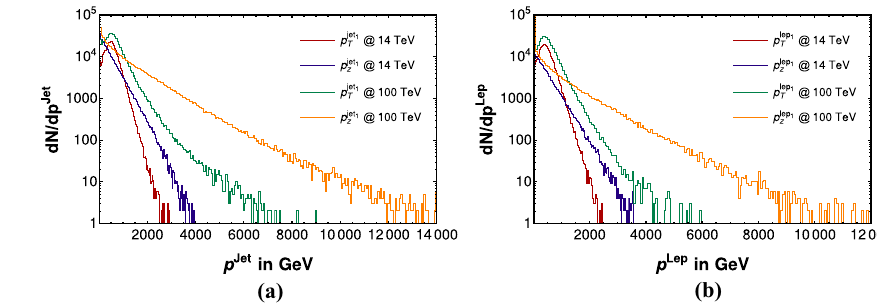
Table 4 The percentage of events for P jet z > P jet c distribution for the benchmark points at centre of mass of energies of 14, 27 and 100 TeV, where P jet c is the point of cross-over for P jet z and P jet shown in Fig. 11 Centre of mass energy